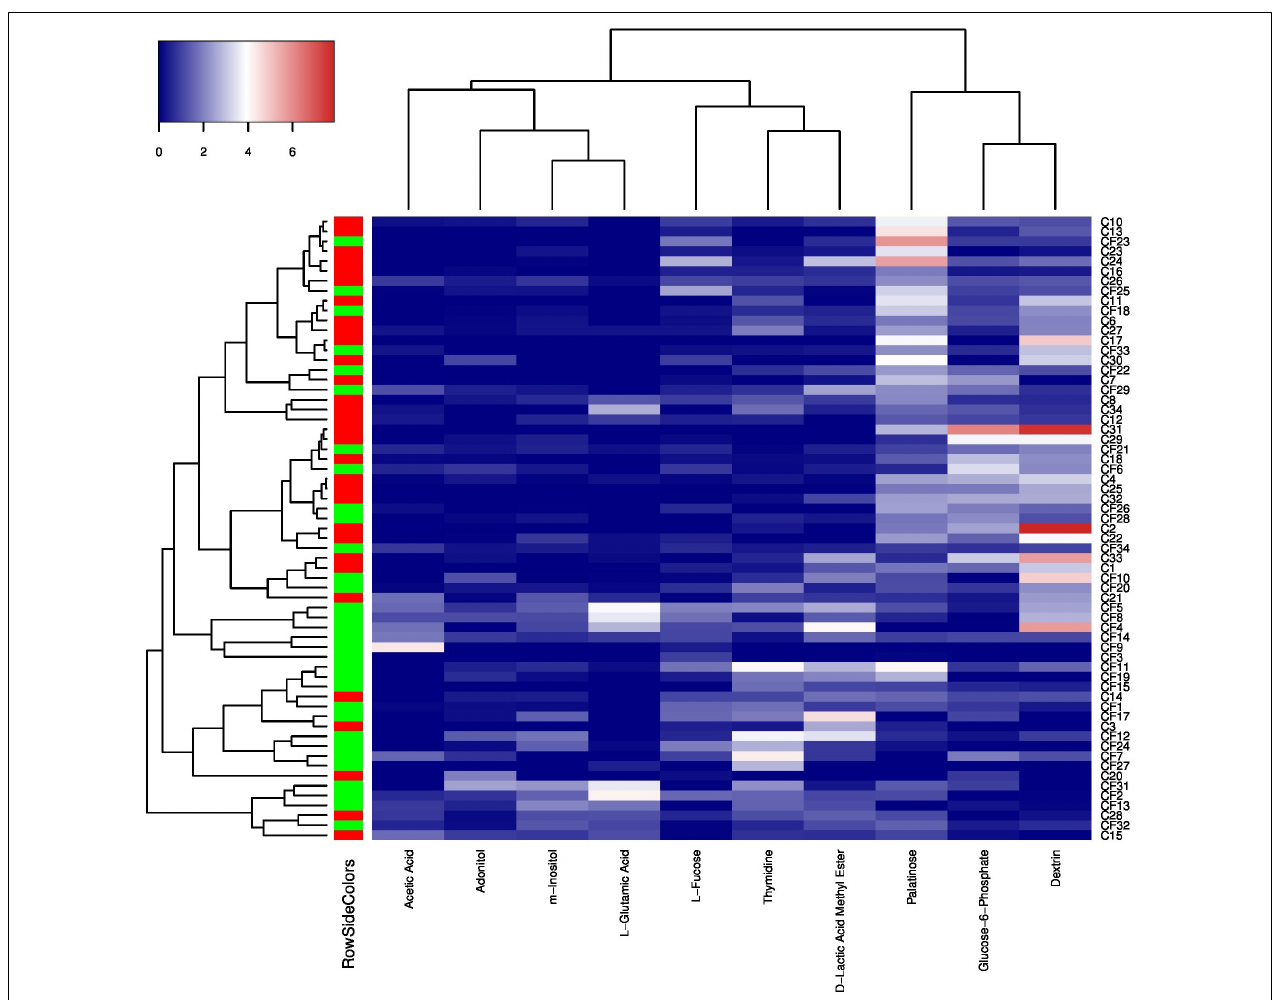
FIGURE 4 | Heatmap cluster analyses of carbon sources utilization patterns and caries states based on 24 h transformed data. The color key represents transformed data, the green RowSideColor represents CF group and the red RowSideColor represent CA group. The carbon sources’ names were listed at the bottom of the heatmap and the sample numbers were listed at the right of the heatmap.